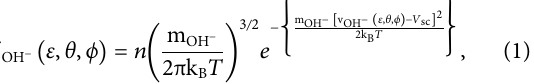
Frontiers in Astronomy and Space Sciences |